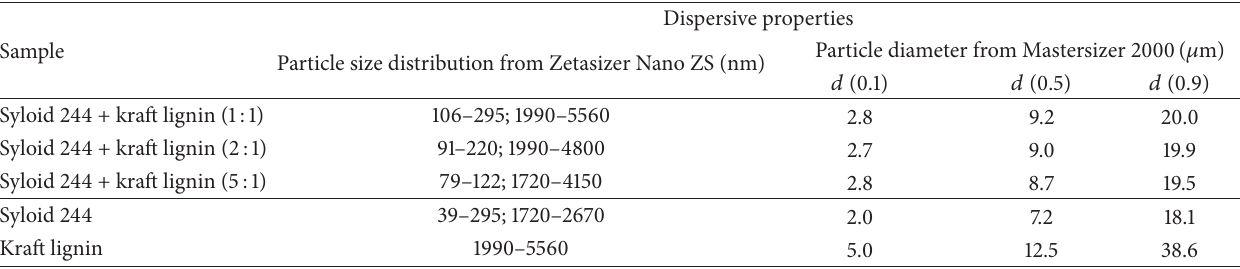
Table 2: Dispersive characteristic of pure precursors (silica and lignin) and silica-lignin hybrid fillers.